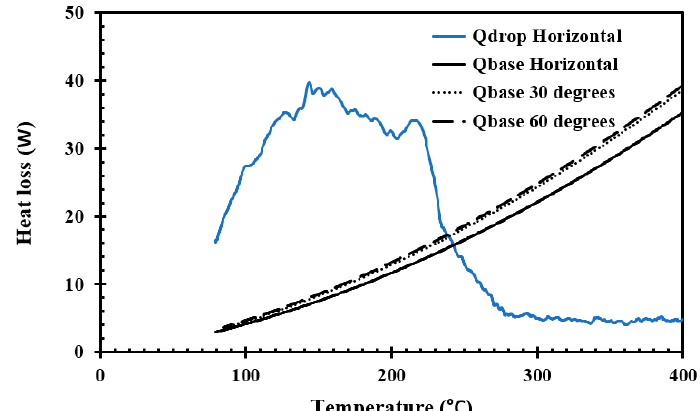
Figure 5. Heat loss to the water droplets in a representative test for droplets impinging a horizontal stainless steel disc, the corresponding dry-cooling (reference) heat loss for the horizontal disc and similar dry-cooling heat losses for 30° and 60° inclined discs.